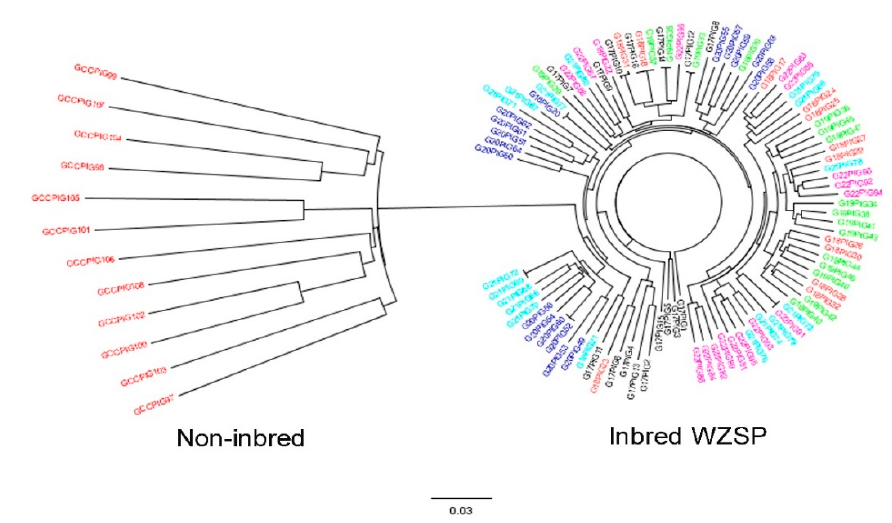
Figure 4. Neighbor-joining tree of the 96 inbred pigs and 12 non-inbred pigs. Individual and breed